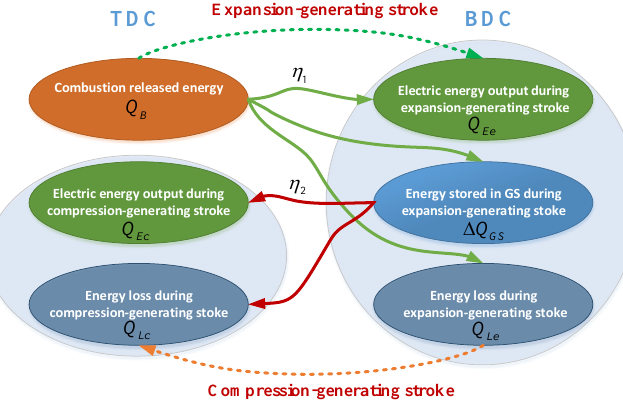
Figure 4. Simplified energy distribution of each operation cycle at stable operation.